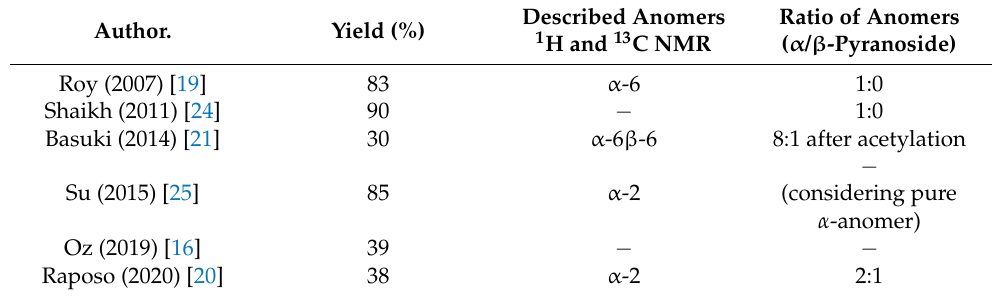
Table 1. Overview of publications, in which sulphuric acid-catalysed propargylation of mannose was performed, and the yields of reactions, anomers, and their ratios are